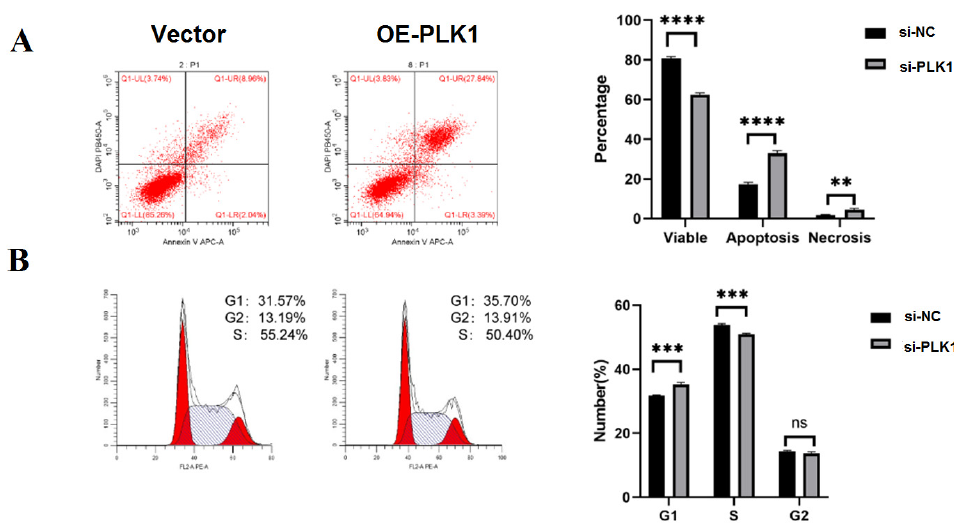
Figure 4. Overexpression of PLK1 suppressed apoptosis and stimulates the proliferation of cells in TE; ( A ) flow cytometry analysis was utilized to measure apoptosis; and ( B ) a flow cytometry study was conducted to compare the two groups’ differing cell cycle patterns; ** p < 0.01, *** p < 0.001, **** p < 0.0001.